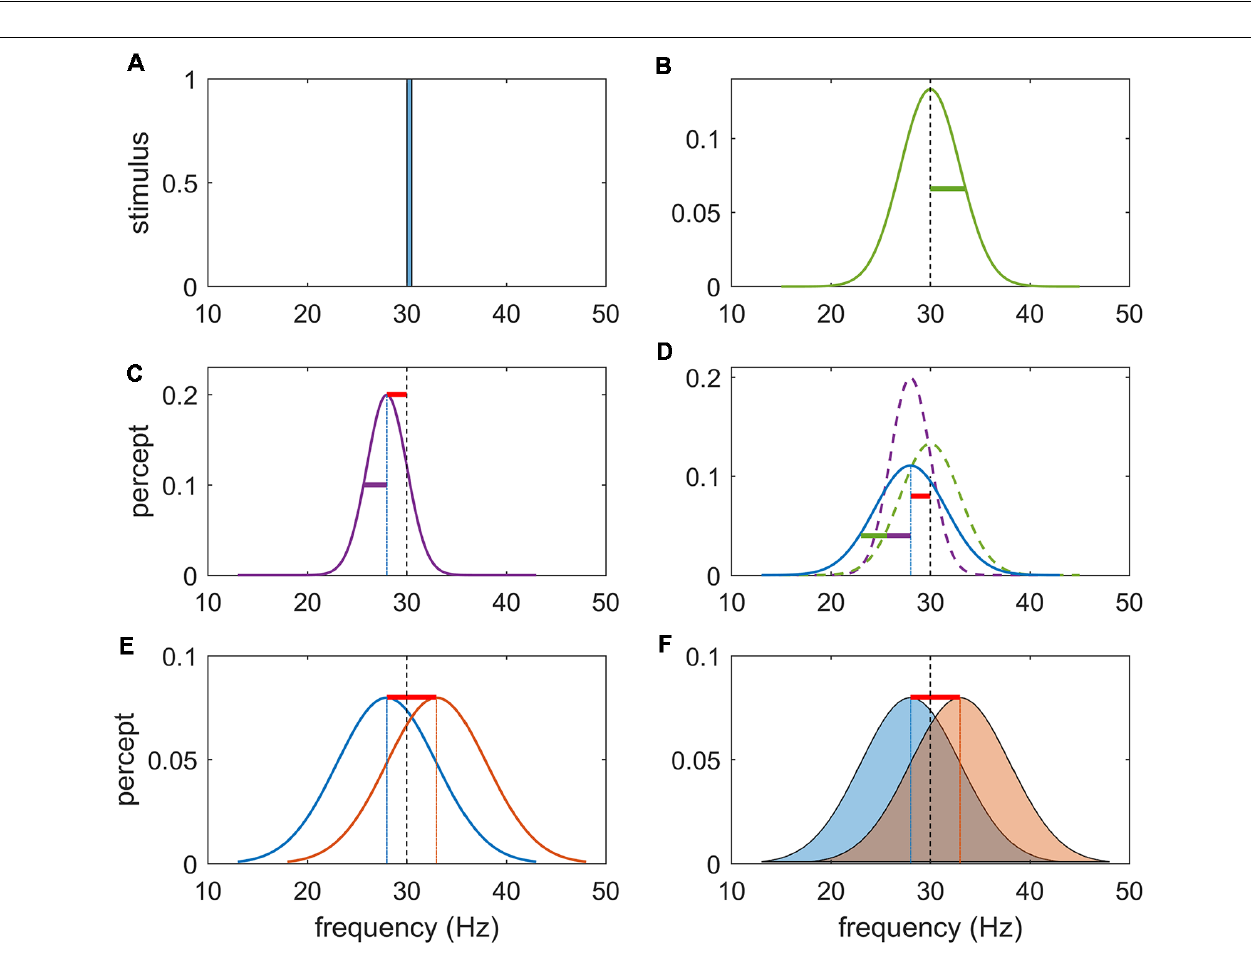
FIGURE 2 | Schema for task rationale. (A) Frequency content of a noise-free stimulus of 30 Hz. (B) Noise imbued vibrotactile stimulus with center frequency of 30 Hz and variance of stimulus noise represented by the green bar. Precision refers to the inverse of the variance of the percept. (C) Perceptual encoding of a noise-free stimulus can be represented by a unimodal distribution centered at the likely value of the inferred stimuli. Note that due to an inevitable perceptual error (bias) this inferred stimulus is shifted to the left (or right) of the true stimulus frequency (red bar) and has perceptual noise (purple bar). (D) Perceptual representation of a noisy stimulus can be conceptualized as the sum of the stimulus (external) noise (green) and the perceptual (internal) noise (purple). It may have a perceptual bias (red bar) and perceptual noise (purple bar) in addition to stimulus noise (green bar). In separate sessions, participants were either instructed to answer the question “Is the 2nd vibration faster?” or “Are the vibrations different?” as a yes/no response. (E) The first task can be solved by subtracting the values of the inferred stimulus and responding on the sign of the answer. (F) The second task requires that the inferred magnitude of this difference be weighted by the precision (inverse variance) of each percept. Due to the perceptual error, there will exist a difference in the inferred frequency difference even if f1 = f2.